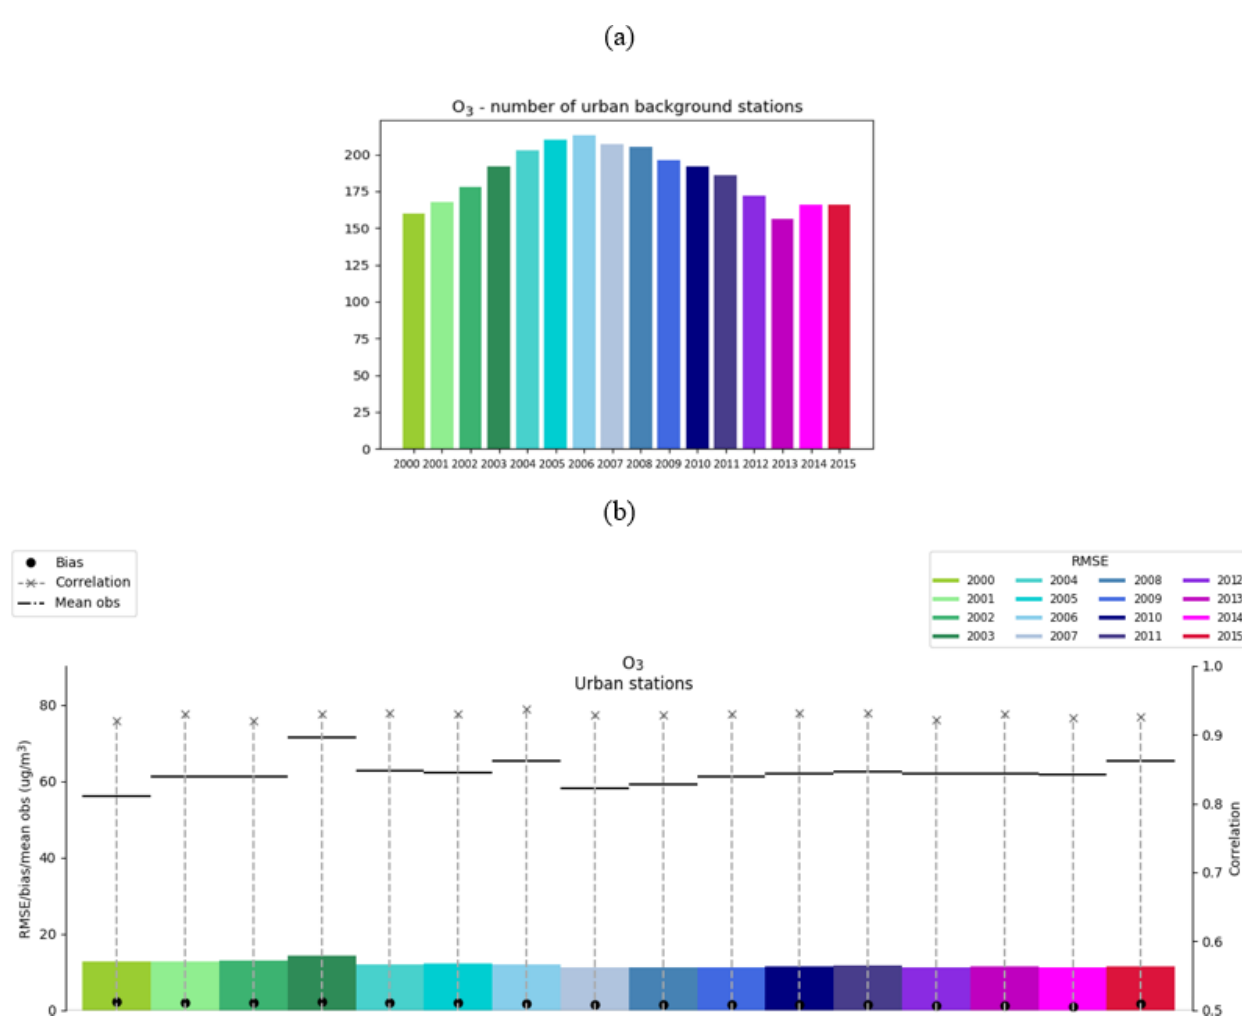
Figure 6. O 3 : statistical indicators calculated using cross-validation technique on daily mean O 3 values measured and estimated over UR- BAN background stations for the years 2000 to 2015. (a) Number of urban stations for each year. (b) Bias (black circles), RMSE (colored rectangles), correlation (grey crosses and the associated dashed lines) and mean observation (horizontal